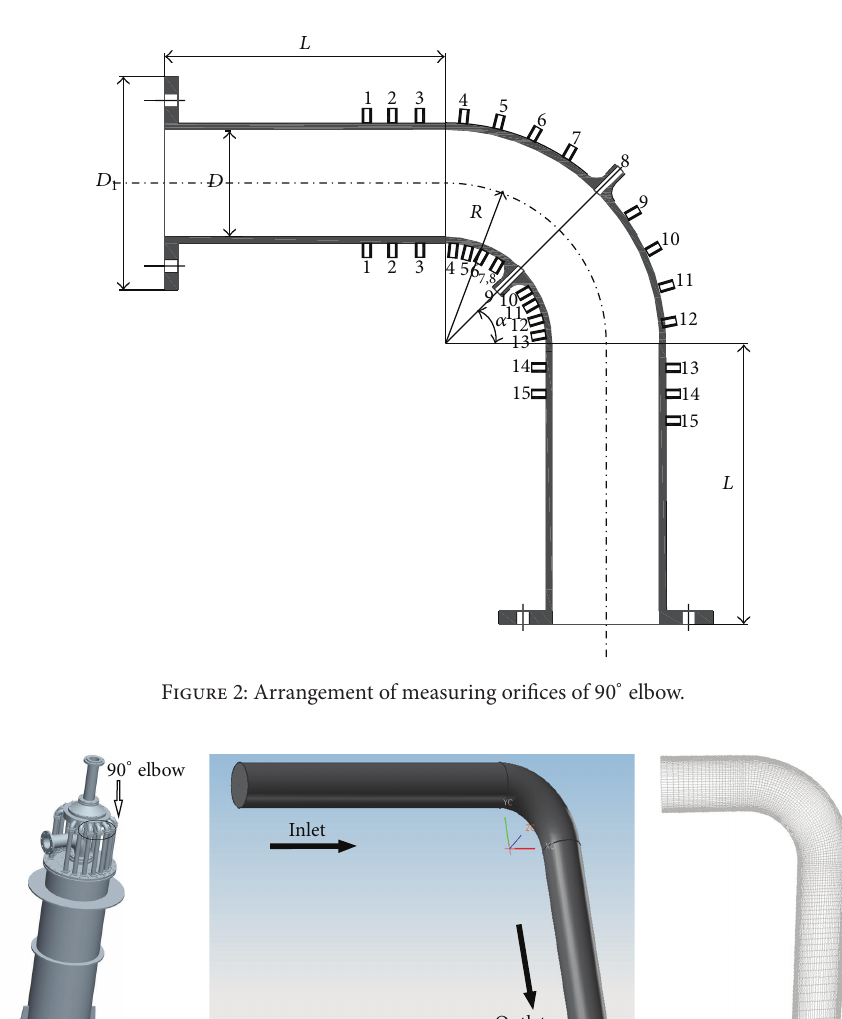
computational domain again to capture more information about the formation and development of the secondary